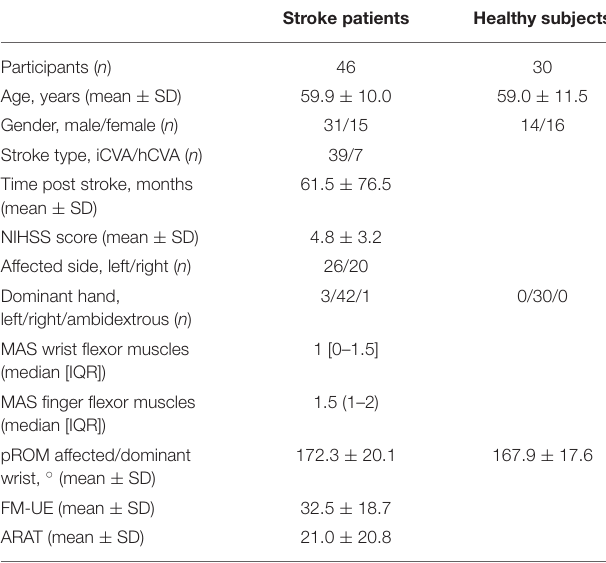
TABLE 1 | Demographic and clinical characteristics of the study